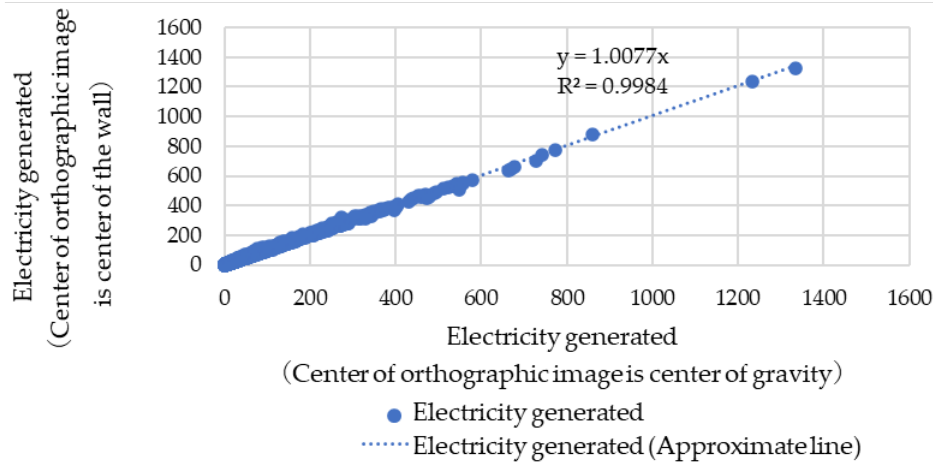
Figure 8. Comparison of electricity generation calculated at building center with that calculated at wall surface.